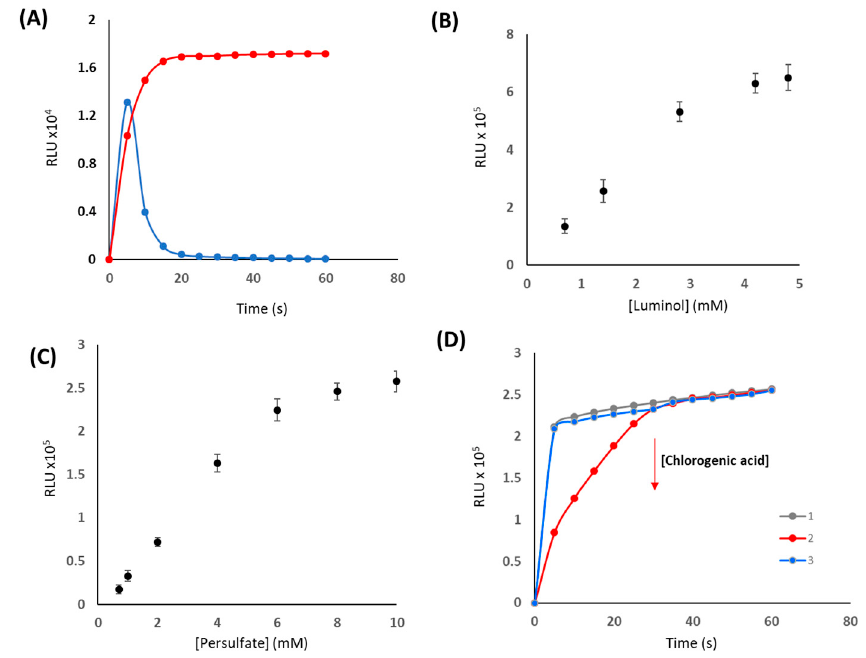
Figure 2. ( A ) Variation of the luminescent signal (RLU) produced by luminol using 0.25 mM hypochlorite (blue) and 0.7 mM persulfate (red); Luminol = 1.4 mM, carbonate buffer 0.3 M, pH 10.8. ( B ) Variation of the RLU as a function of luminol concentration, ( C ) Variation of the RLU as a function of persulfate concentration, ( D ) Variation of the RLU signal in presence of CHLA (50 μ M, pH 10.8) for blank (1, grey), luminol ‐ persulfate, CHLA addition at t = 5 min (2, red) and persulfate ‐ CHLA luminol addition at t = 10 min (3, blue). Conditions: 10 mM persulfate, 1.4 mM luminol.